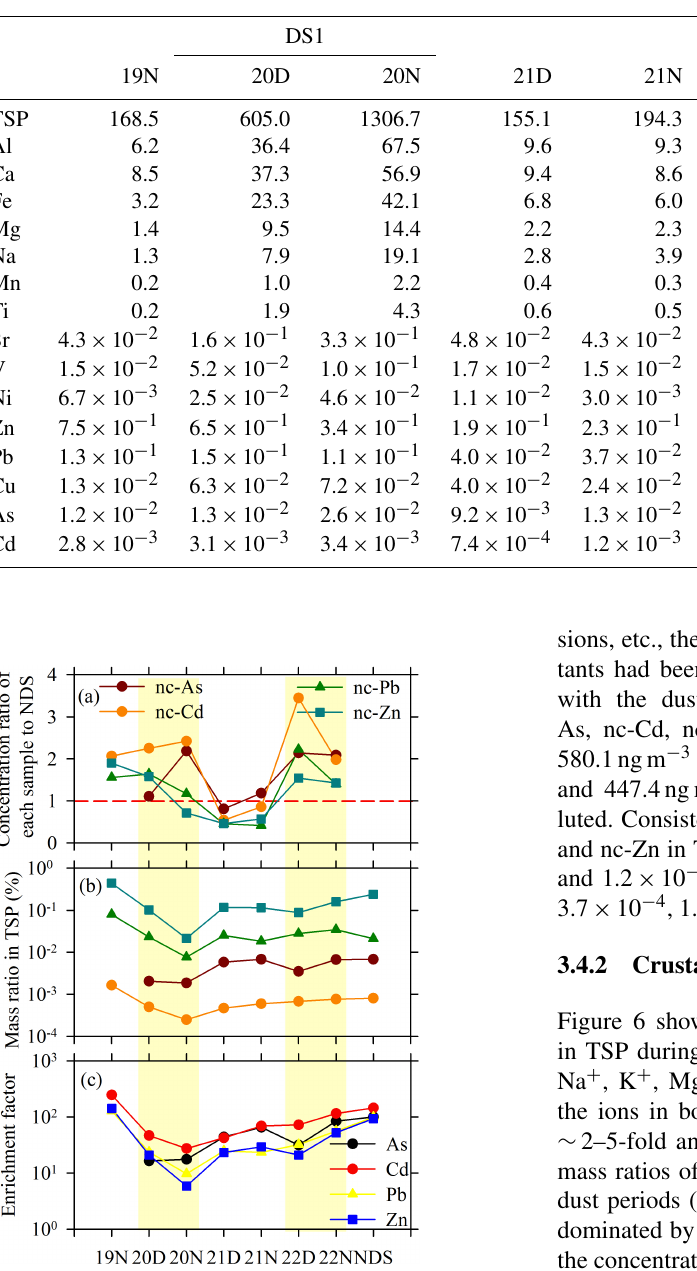
Table 1. Concentrations of the measured elements (µgm − 3 ) in TSP before, during, and after the dust periods from 19 to 22 March and on non-dust (NDS) days in Shanghai. N, D, and NDS represent the nighttime samples collected from 20:00 to 08:00LST on the next day, the